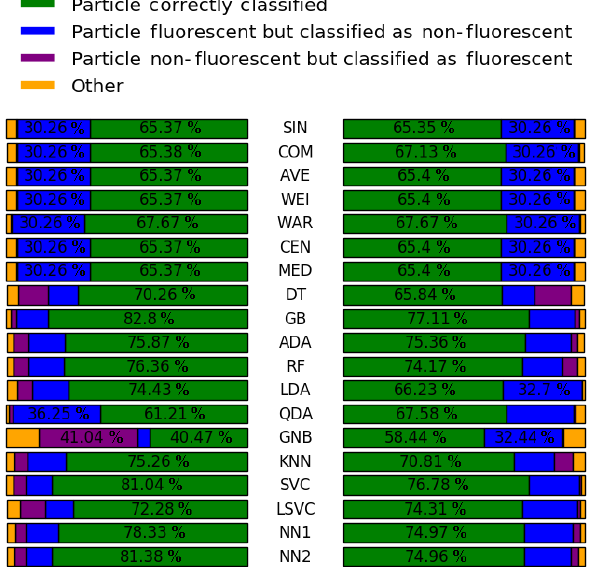
Figure 7. Performance of the different methods in terms of particles correctly classified for the mixed PSLs. The results on the left are for the full data set and on the right are the results for the reduced data set. Full names of each of the methods are given in Table 3.